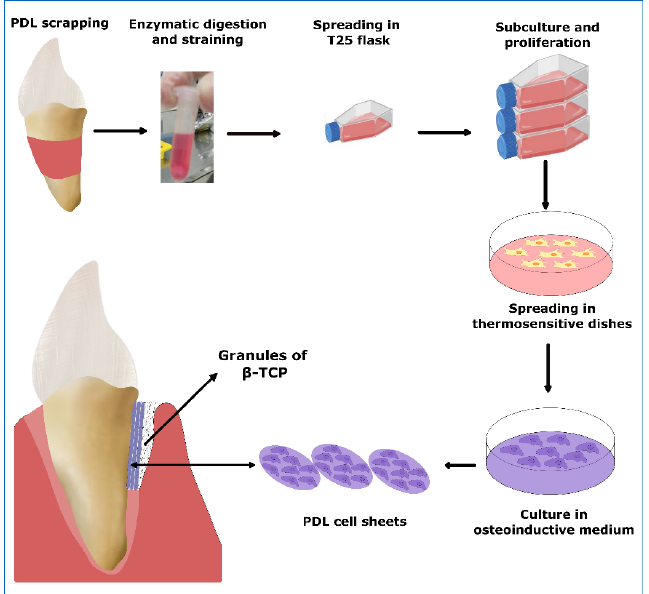
Figure 3. Schematic representation of the clinical model applied by Iwata et al. [70] for cell sheet transplantation.